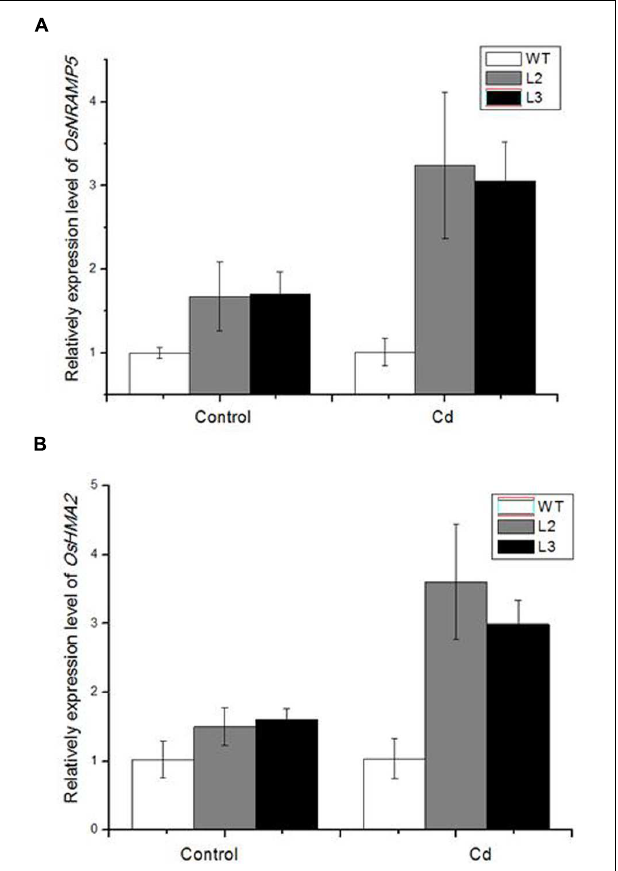
FIGURE 7 | Quantitative real-time PCR (QPCR) analysis of metal transporter genes in 35S:MIR390 transgenic plant roots compare with wild-type plants under Cd stress. (A) OsNRAMP5 . (B) OsHMA2 . Normalized expression levels were calculated with the 2 − (cid:49)(cid:49) C ( t ) method using OsACTB as the internal reference